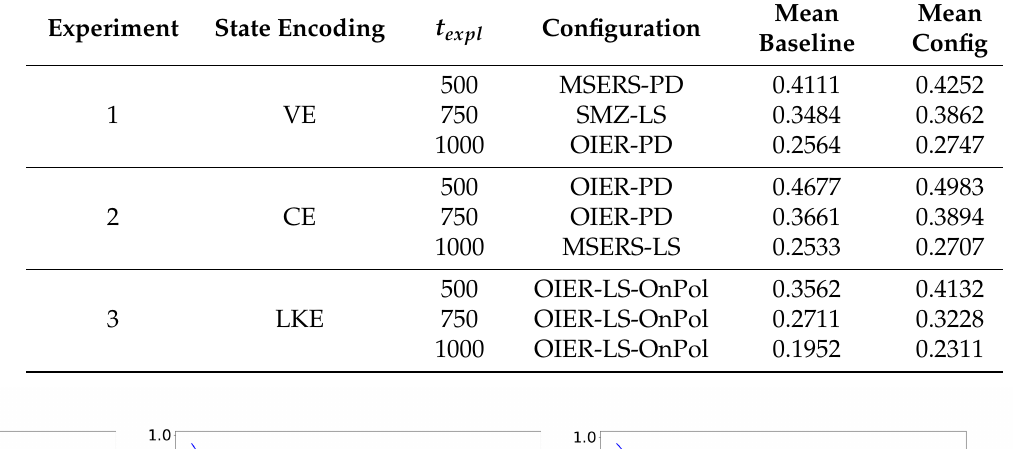
Table 6. Best IER configurations found during the evaluation. The last two columns depict the overall received mean reward of the configuration and its corresponding baseline. A higher value indicates better performance.